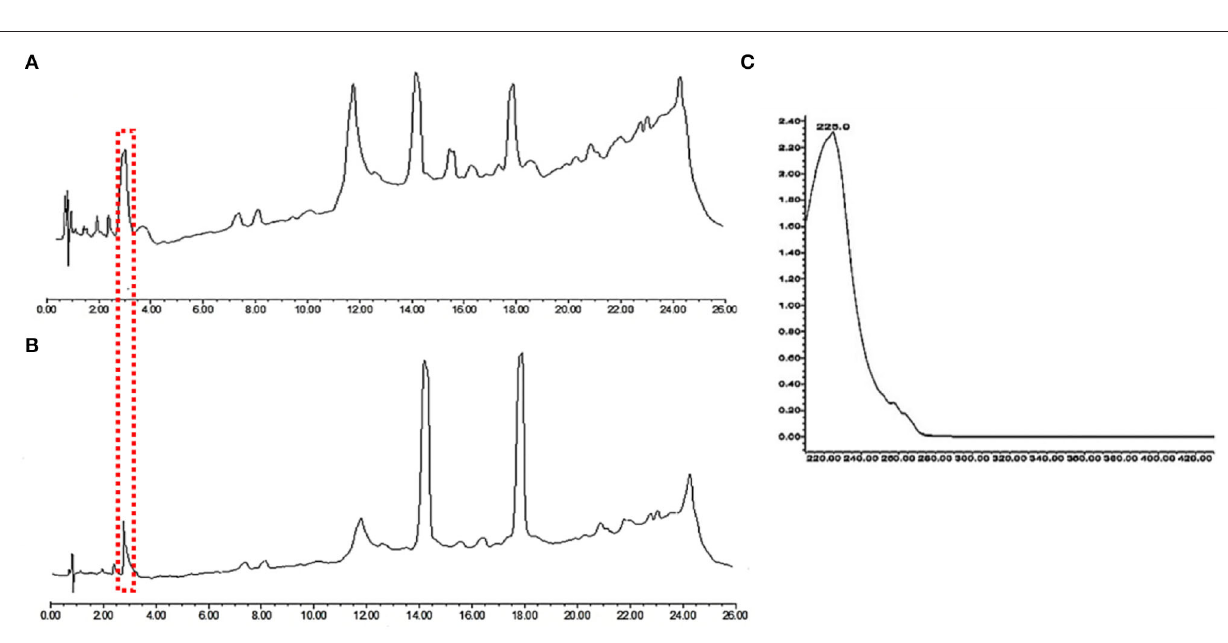
FIGURE 11 | Comparison of eluted products of M. ruber M7 and 1 abct 31 transformant for solid-state fermentation on rice. (A) Metabolic profile of M. ruber M7 at 250nm; (B) Metabolic profile of 1 abct 31 at 250nm; (C) UV-Vis spectrum of benzyl penicillin (PG) which is shown by the arrows in metabolic